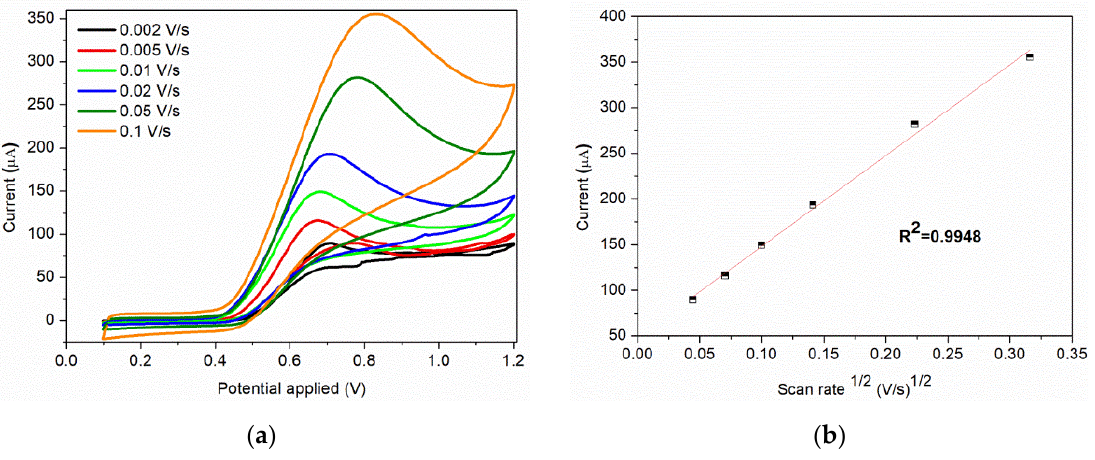
Figure 8. ( a ) Cyclic voltammograms of 7 × 10 − 3 M nitrite solution at various scan rates; ( b ) Corre- sponding plot of peak current vs. square root of scan rate at 7 × 10 − 3 M nitrite.